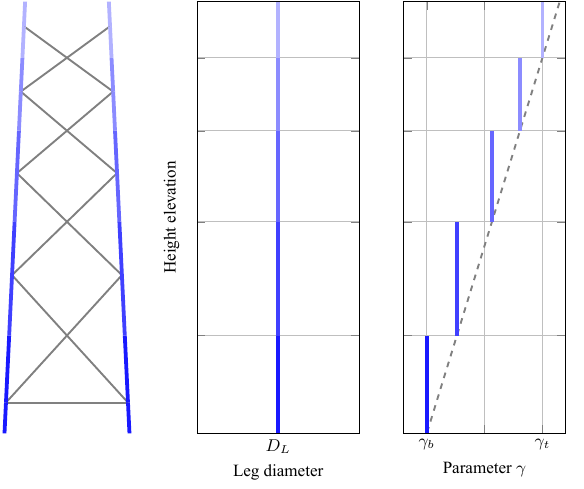
Figure 5. Definition of brace dimensions with a dependency on the jacket height. Values are illustrated by darker coloring at the bottom and shade to lighter at the top of the